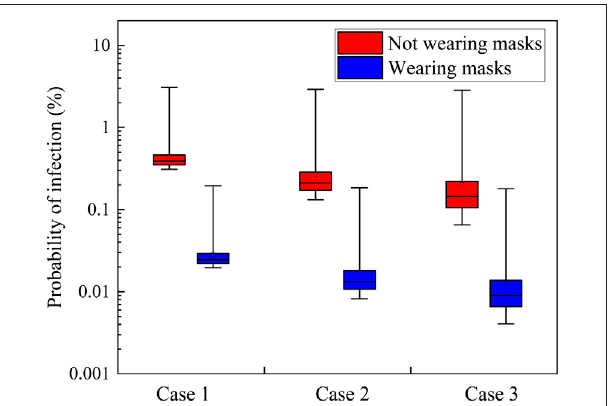
FIGURE 9 | Probability of infection when wearing or not wearing masks for Cases 1 – 3.